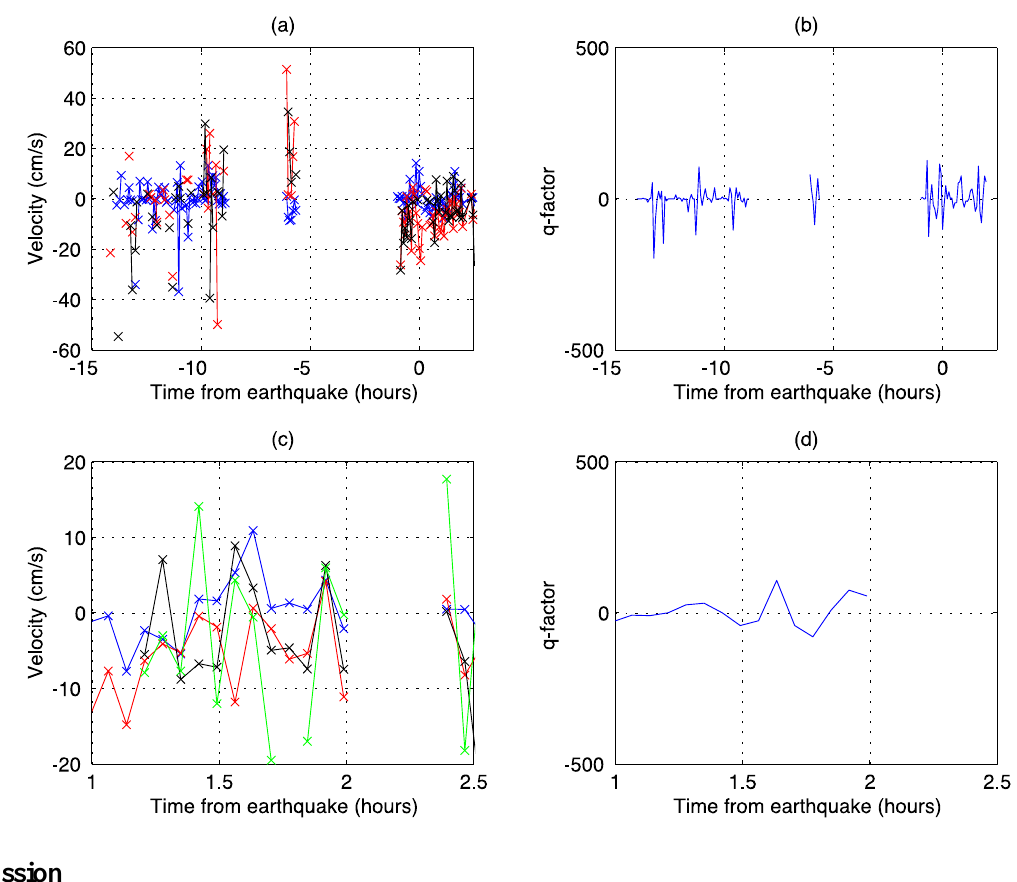
Figure 7. PTBL radar observations 11 April 2012. ( a ) Velocity vs. time from 8:38 UTC. Blue: 0–6 km; Red: 6–12 km; Black: 12–18 km. ( b ) The q-factor corresponding to (a). ( c ) Velocity vs. time for 1.5 hours surrounding the arrival of the tsunami. Blue: 0–6 km; Red: 6–12 km; Black: 12–18 km, Green: 18–24 km, showing correlated peaks at the 10:28, followed by a data gap. ( d ) The q-factor corresponding to